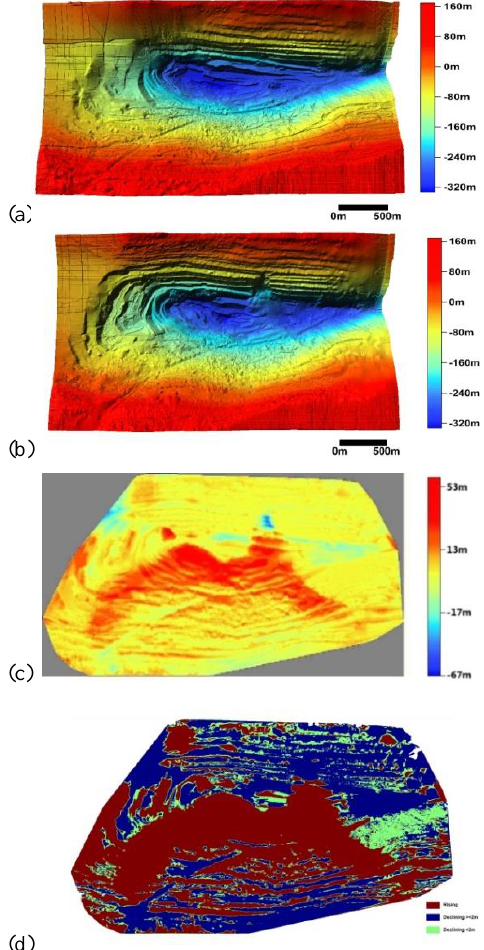
Figure 9 Deformation extraction using LiDAR DEMs in 2013 and 2014 in the case study. (a) LiDAR DEM of November 2013; (b) LiDAR DEM of August 2014; (c) Deformation from 2013 to 2014; (d) Distribution of deformation with rising or declining